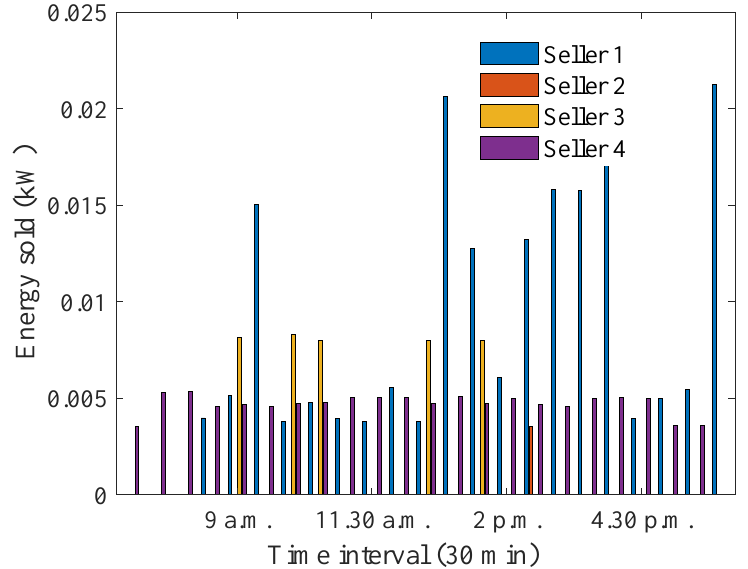
Figure 3. Optimum energy sold during winter months.